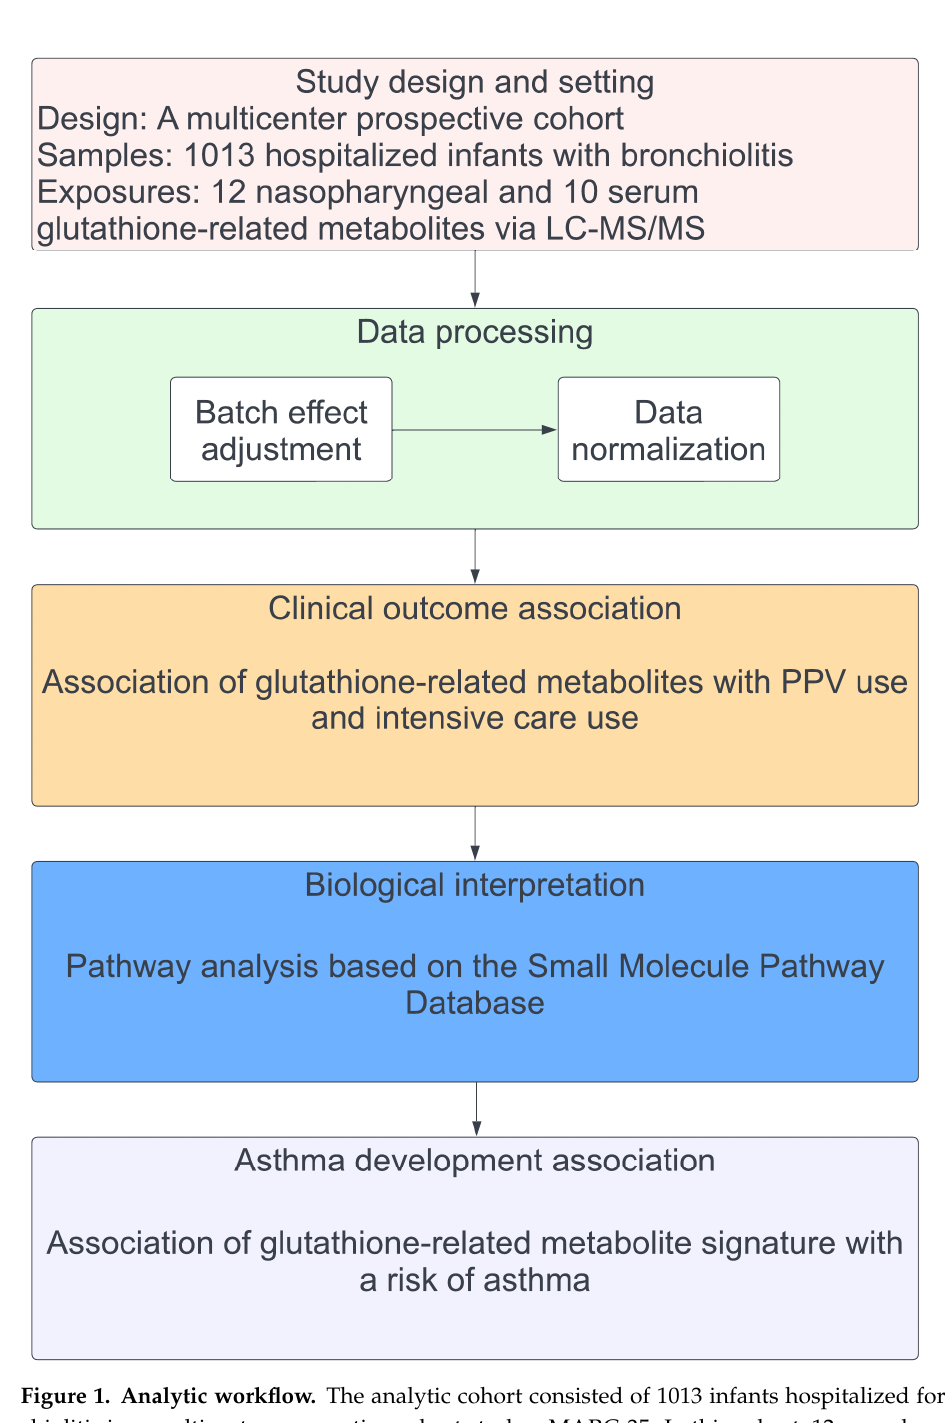
Figure 1. Analytic workflow. The analytic cohort consisted of 1013 infants hospitalized for bronchiolitis in a multicenter prospective cohort study—MARC-35. In this cohort, 12 nasopharyngeal airway and 10 serum glutathione-related metabolites were identified by using liquid chromatography– tandem mass spectrometry (LC-MS/MS). The glutathione-related metabolites data were adjusted for the potential batch effect and normalized. The association of the glutathione-related metabolites with the risk of PPV use and intensive care use was estimated. To examine the biological function of the measured metabolites, metabolite set enrichment analysis was conducted. The nasopharyngeal and serum glutathione-related metabolite signatures for PPV use were estimated. Then, the association of the signature with the risk of developing asthma was estimated. Abbreviations: LC-MS/MS, liquid chromatography–tandem mass spectrometry; PPV, positive pressure ventilation.